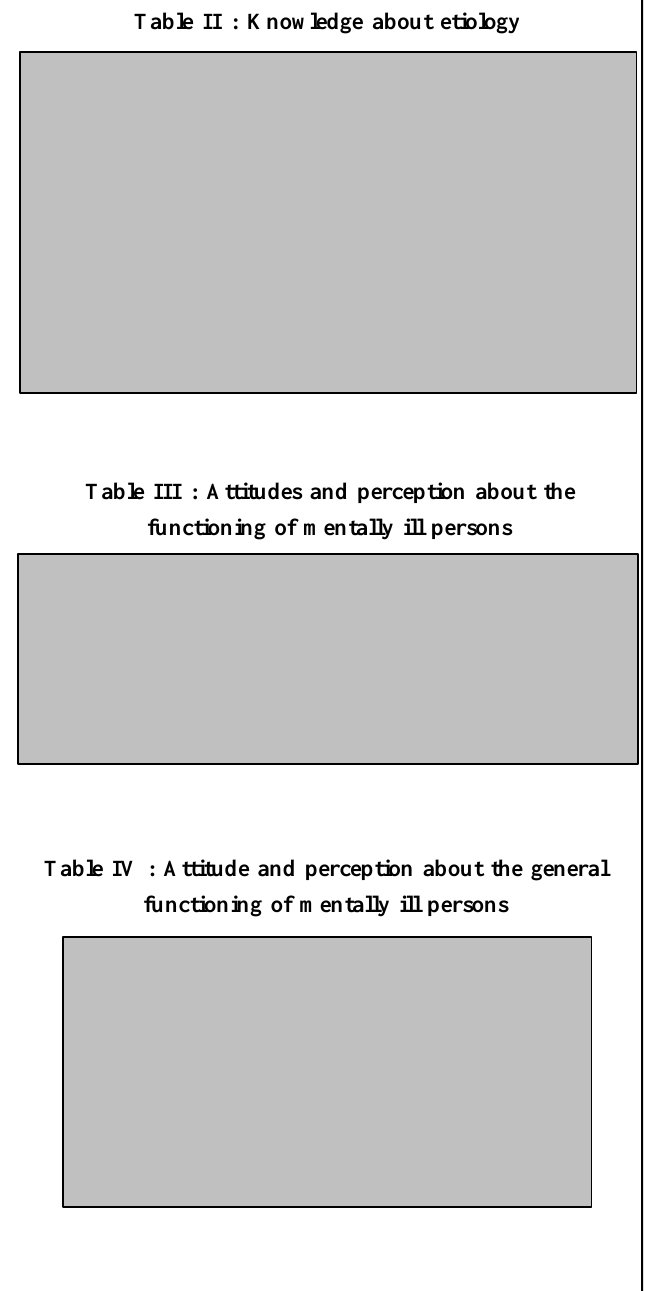
Table I : General perception regarding mental illness